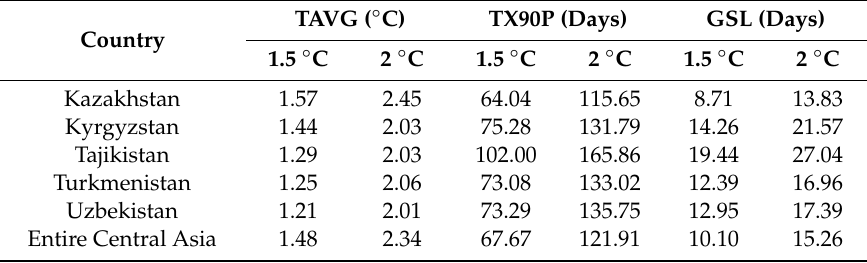
Table 4. Changes in temperature extreme indices under 1.5 ◦ C and 2 ◦ C global warming.